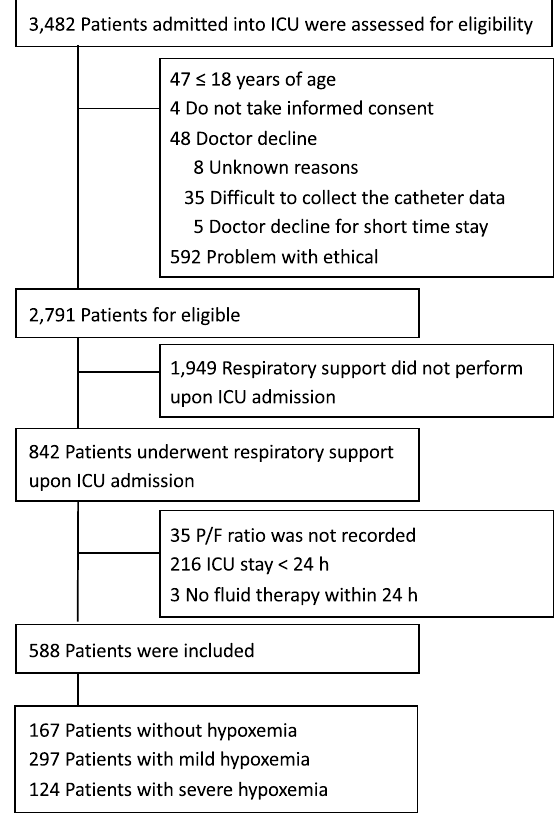
Fig. 1 Patient flow diagram . Abbreviations: ICU, intensive care unit; P/F ratio, ratio of arterial oxygen partial pressure to fractional inspired